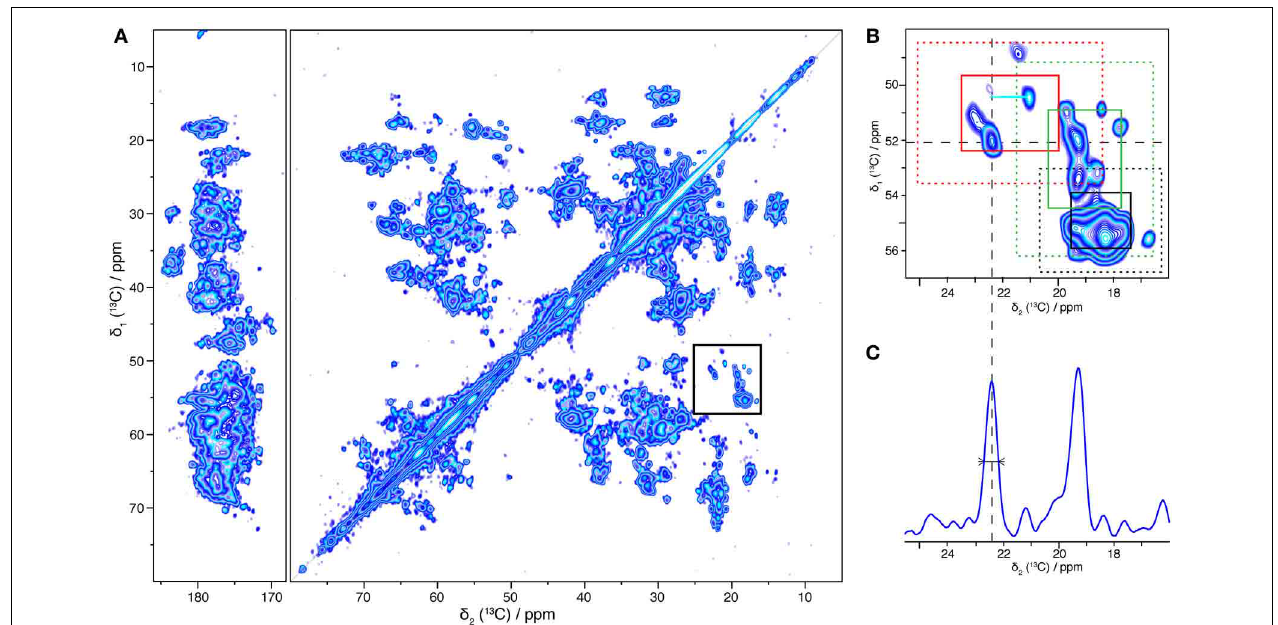
rectangles: solid lines correspond to the mean value + / − standard deviation and dashed lines to the mean value + / − 2 times the standard deviation (Wang and Jardetzky, 2002). (C) 1D trace taken at 52.1ppm, the linewidth at half height is